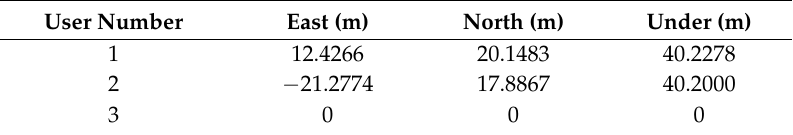
Table 3. The users’ coordinates of the actual